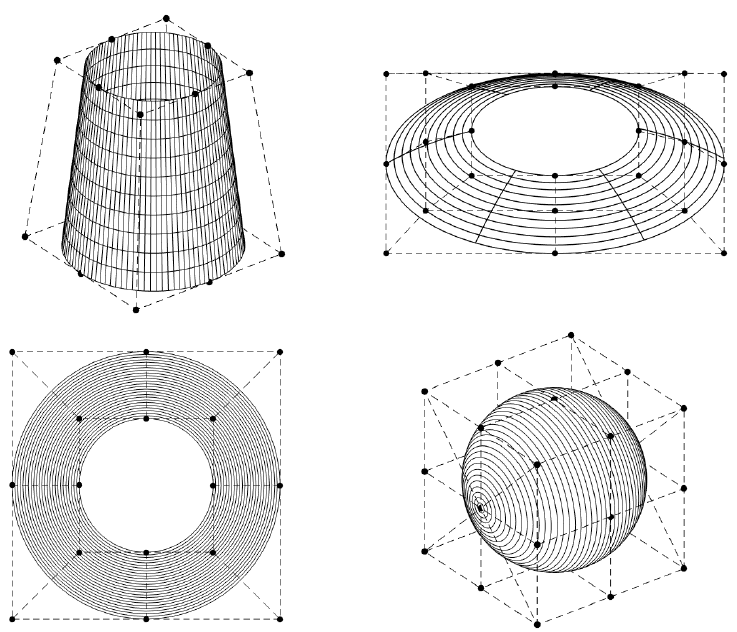
Figure 3: Examples of surface geometries represented by NURBS with their control points (filled dots) and control net (dashed